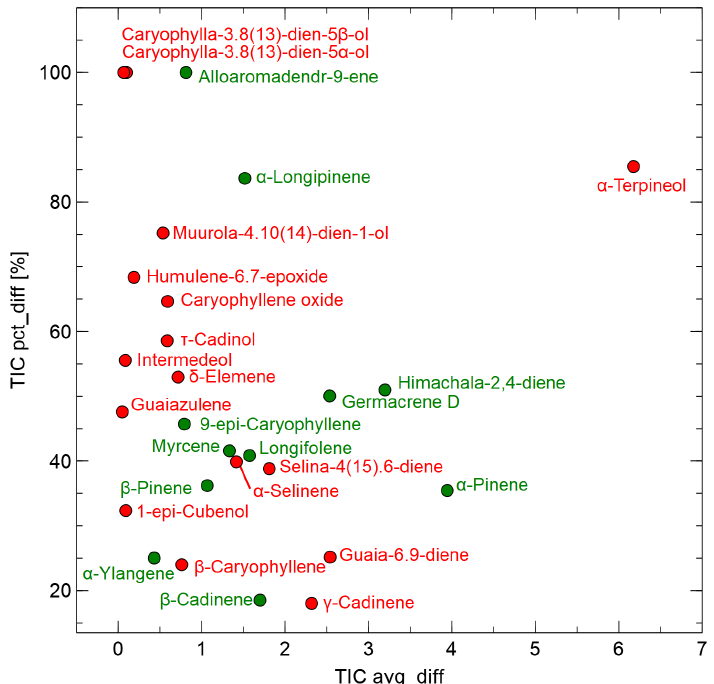
Figure 7. Chemical components identified by the GC-MS method where relative amounts differed significantly between uninfected and infected samples. The x-axis presents absolute value of the difference of Total Ion Current (TIC) averages for samples categories (TIC avg_diff = | TIC Uninfected –TIC Infected | ). Sign of such difference, representing which samples category contain more of the component is indicated by the marker color: green = uninfected, red = infected. The y-axis represents the percent related to the average of TIC for all samples (TIC pct_diff = TIC avg_diff/2 TIC All ).